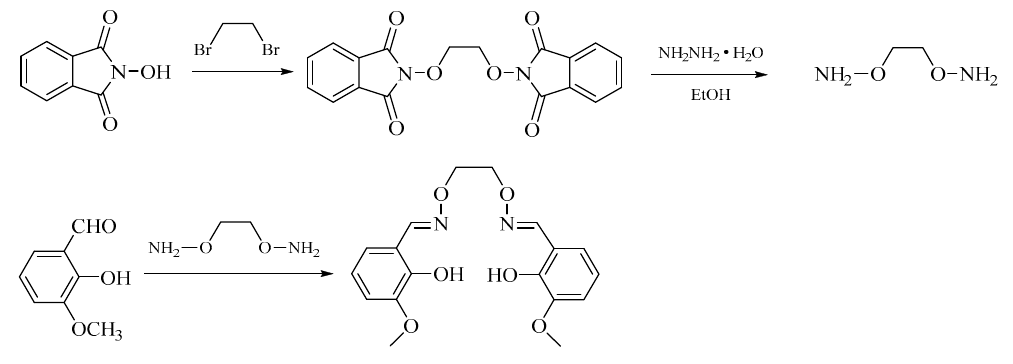
Scheme 1. Synthetic route to H 2 L.